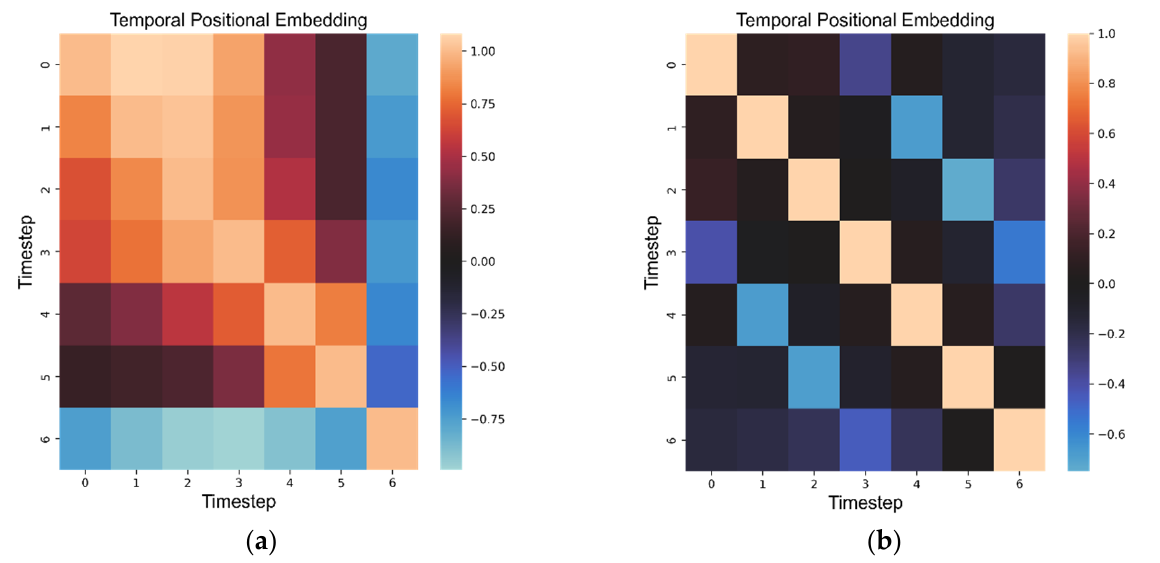
Figure 8. Cosine similarity of temporal position embedding. ( a ) The left side shows the position embedding for the encoder part. ( b ) The right side shows the position embedding for the decoder part.